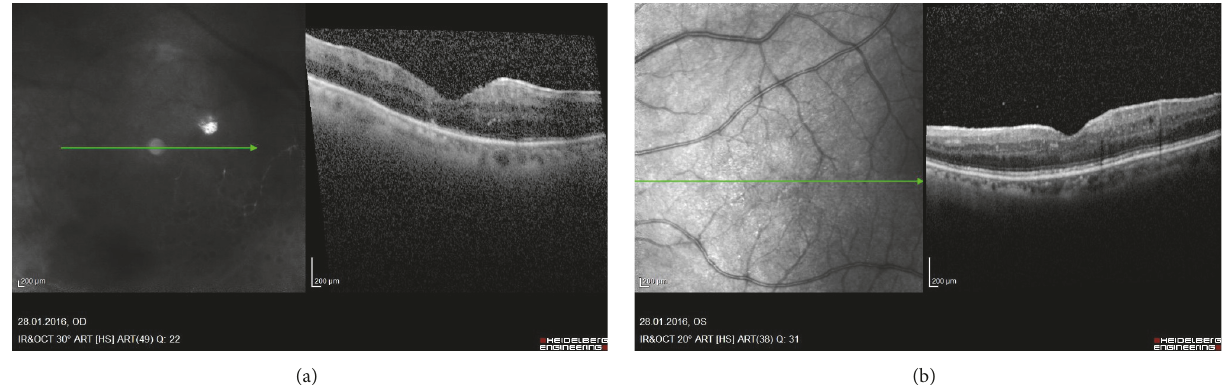
Figure 1: (a) RE, inflammatory cells in vitreous humor, epiretinal membrane,preserved foveal architecturewith parafoveal retinal thickening (mild macular edema), without cysts or serous detachment (b) LE, inflammatory cells in vitreous humor, epiretinal membrane without traction, preserved foveal architecture without cysts or serous